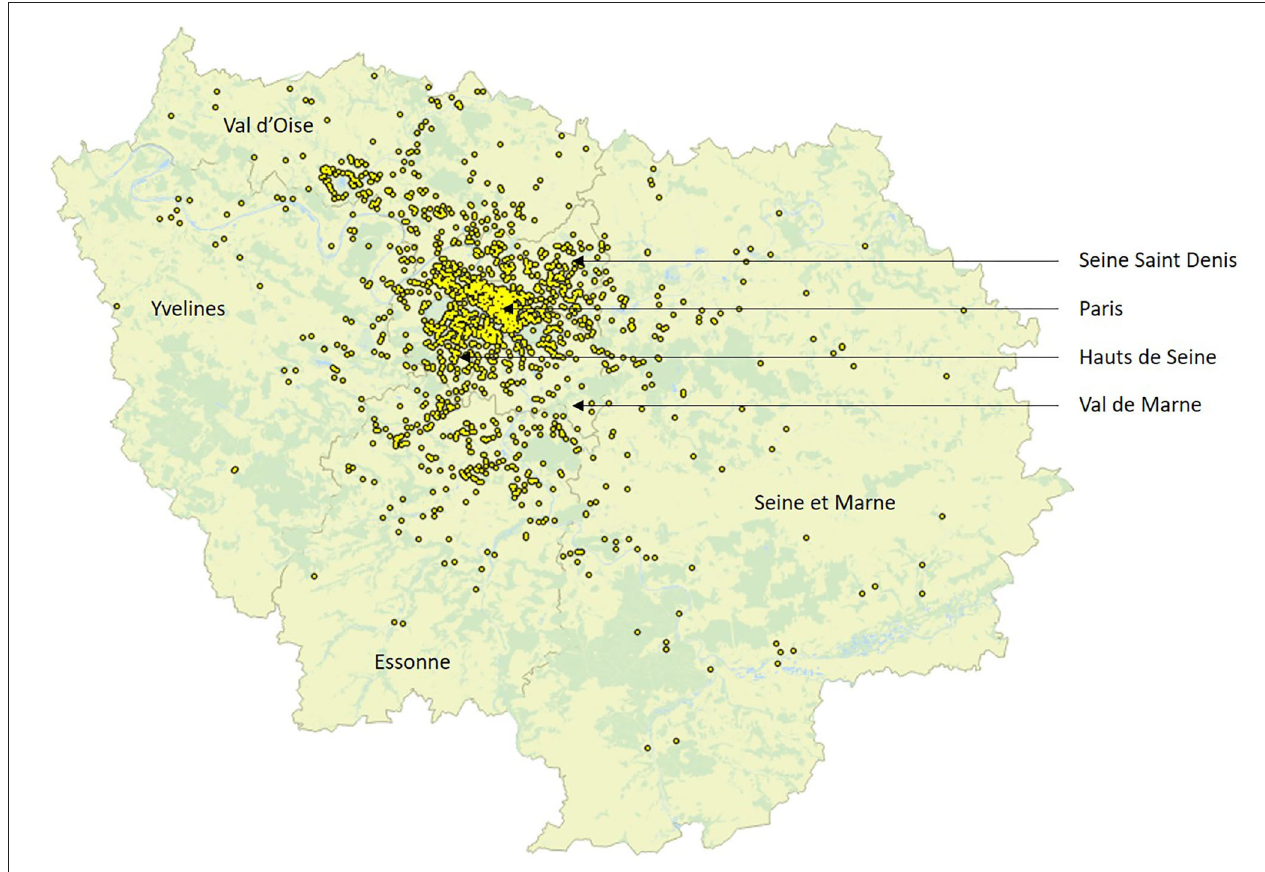
FIGURE 1 | Home address of included patients in Ile de